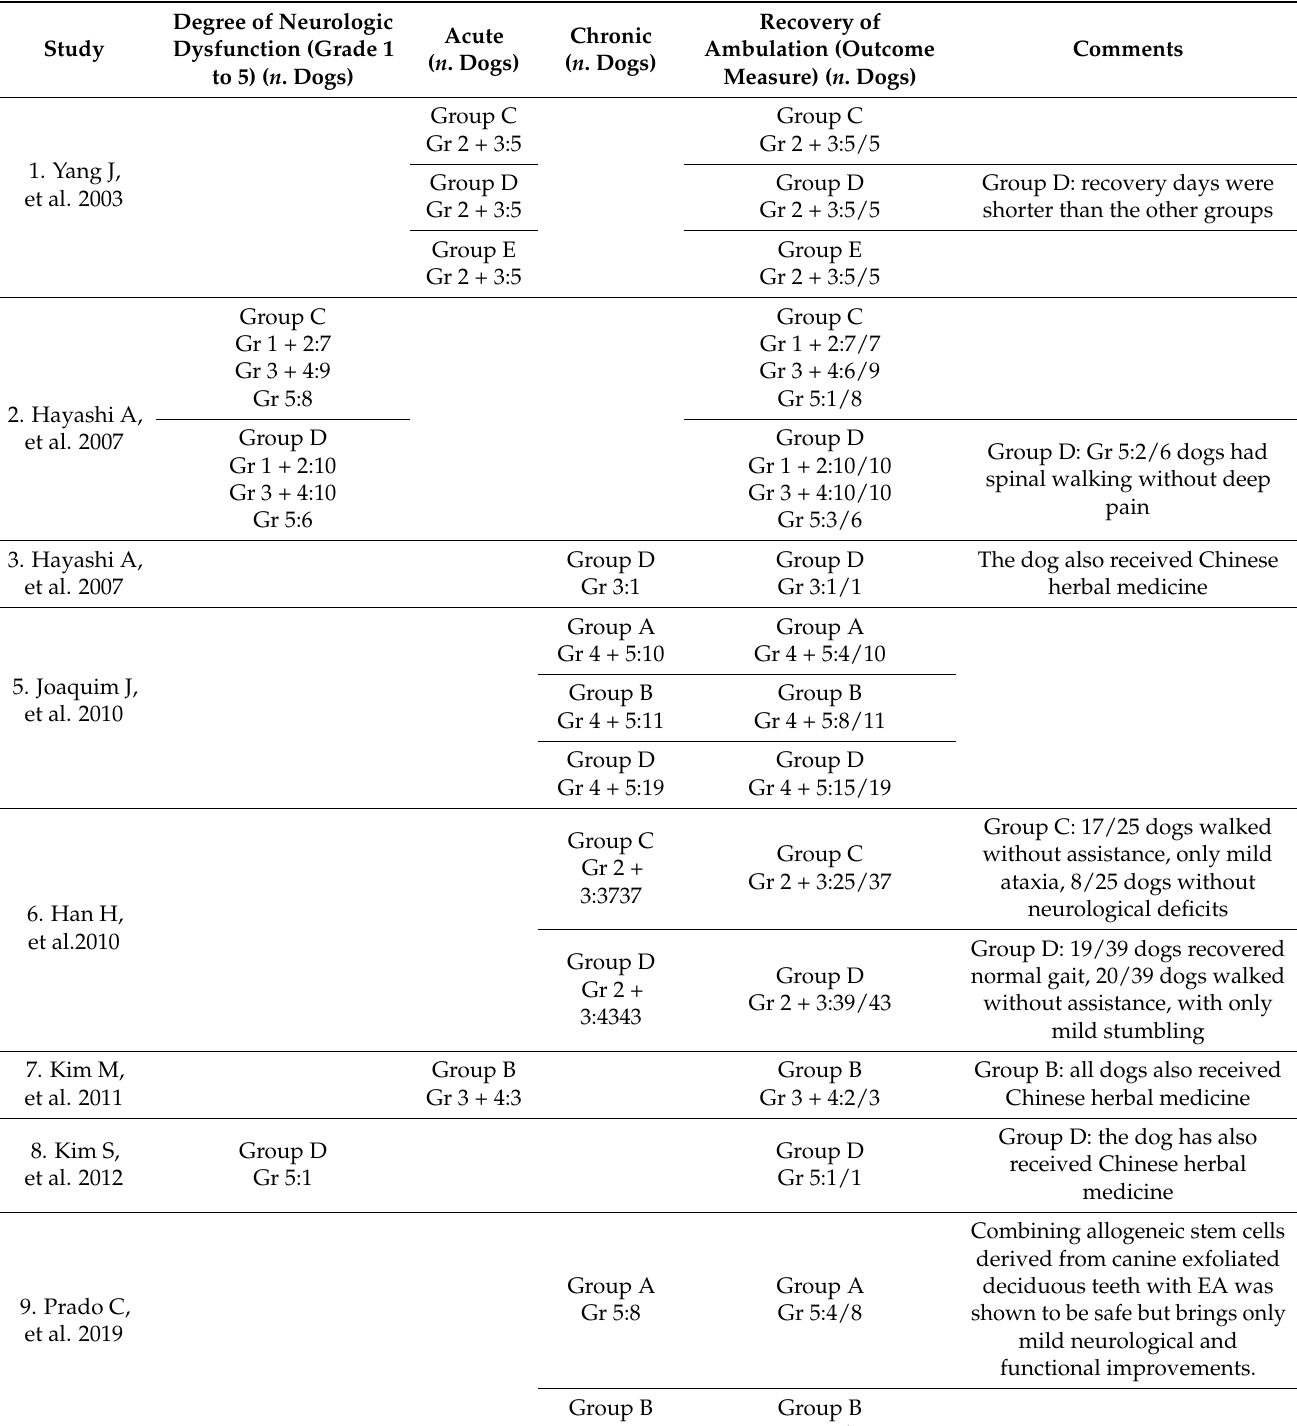
Table 1. Neurological dysfunction